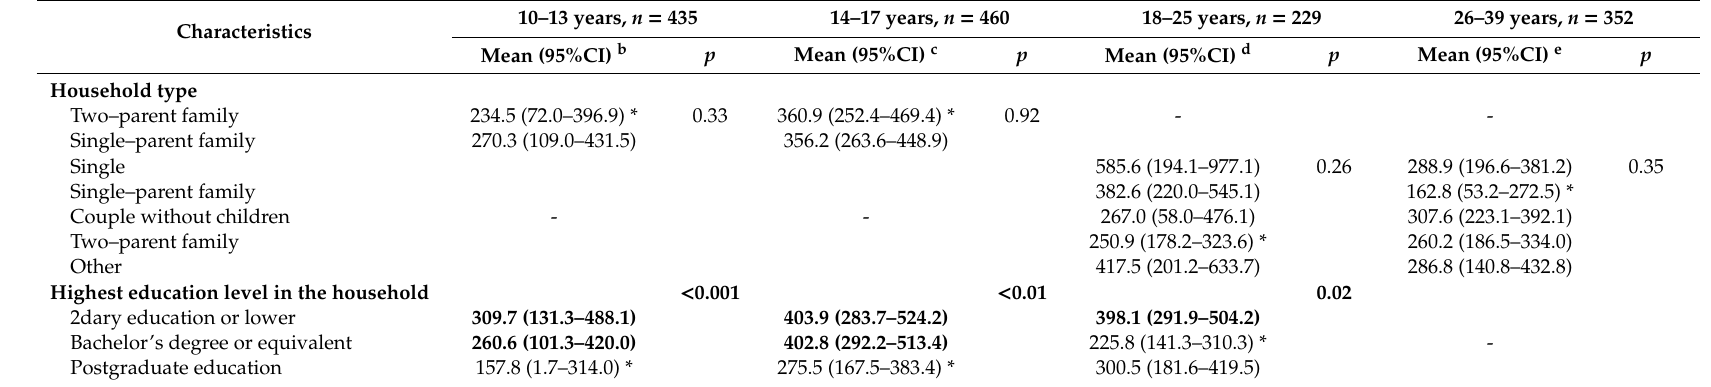
Table 5. Adjusted a mean consumption (g / day) of sugary sweetened beverages according to socio-economic and cultural characteristics, and age group. Belgian food consumption survey